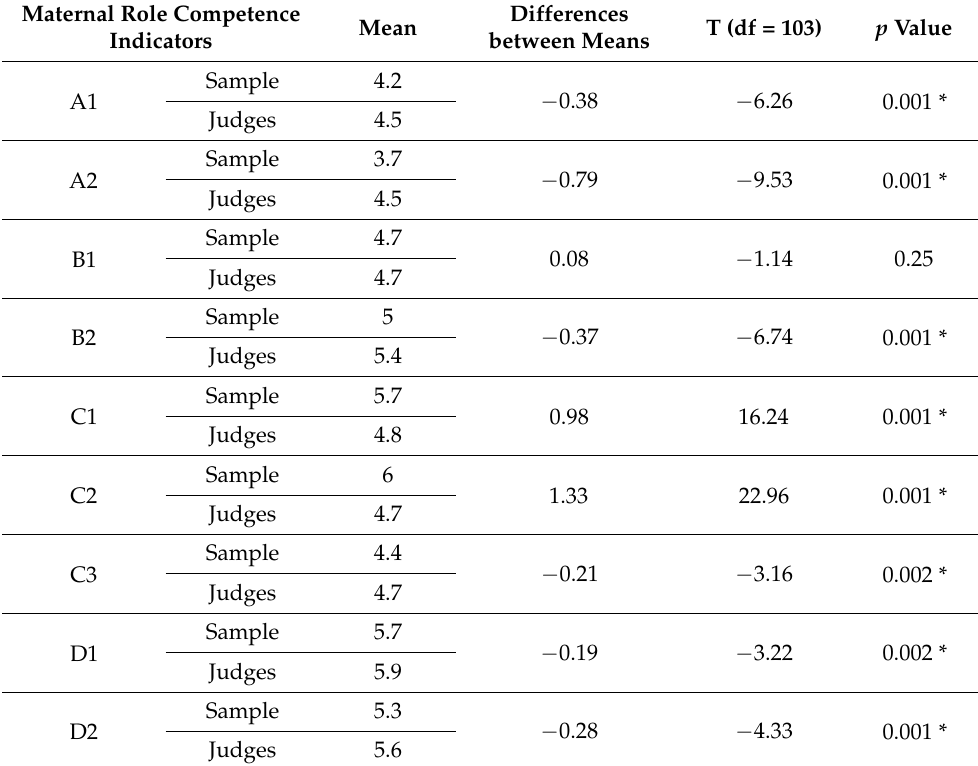
Table 2. Comparison between the Q-sort scores obtained by the sample and the maternal role competence criteria at T1 (paired sample t -test) ( n =